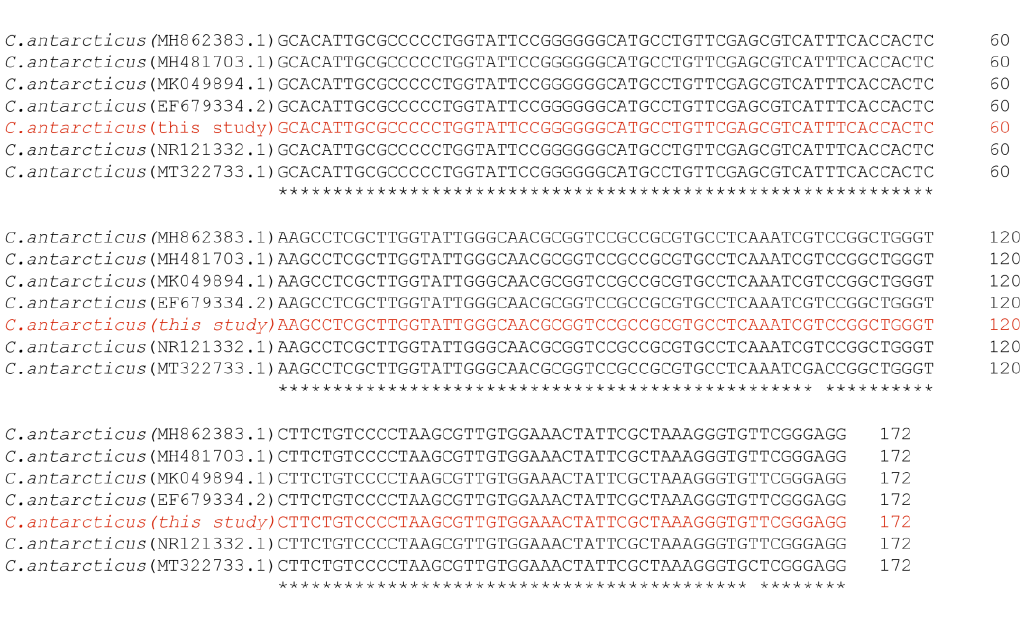
Figure 1. ( A ) Picture of the sampling place in Collins Glacier S 62°09 ′ 51 ″ W 58°51 ′ 00 ″ . ( B ) Scanning electron micrograph of Cladosporium antarcticum.